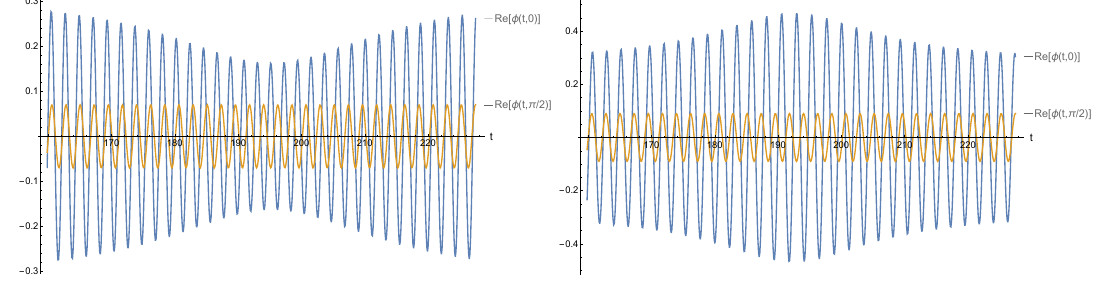
Figure 8 . For small values of the driving amplitude and the scalar (cid:12)eld modulus at origin, here (cid:26) b = 10 (cid:0) 3 and (cid:26) o = 0 : 3, perturbations along the unstable mode (cid:15) 1 (cid:31) 1 with both signs (cid:15) 1 = (cid:6) 10 (cid:0)